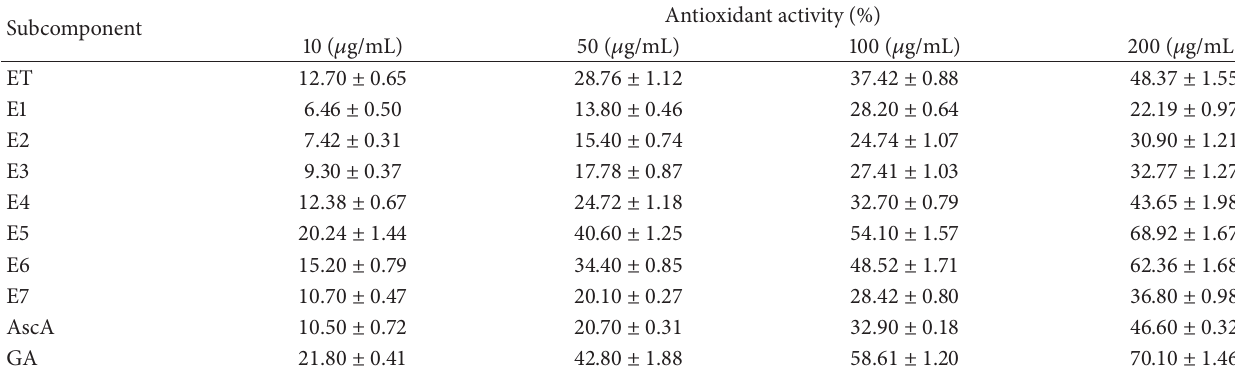
Table 4: Antioxidant activity of subcomponents E1–E7 isolated from ET in the 𝛽 -carotene-linoleic acid system.